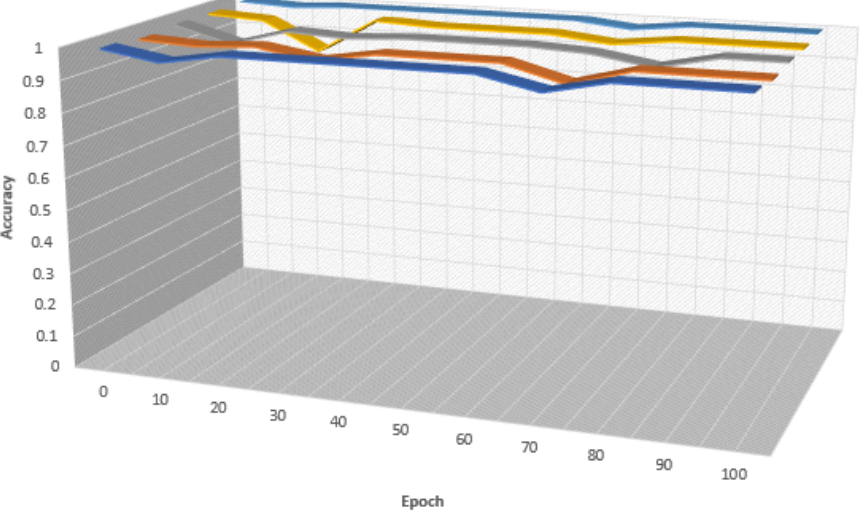
Figure 8. 10-Fold Accuracy and Epoch.